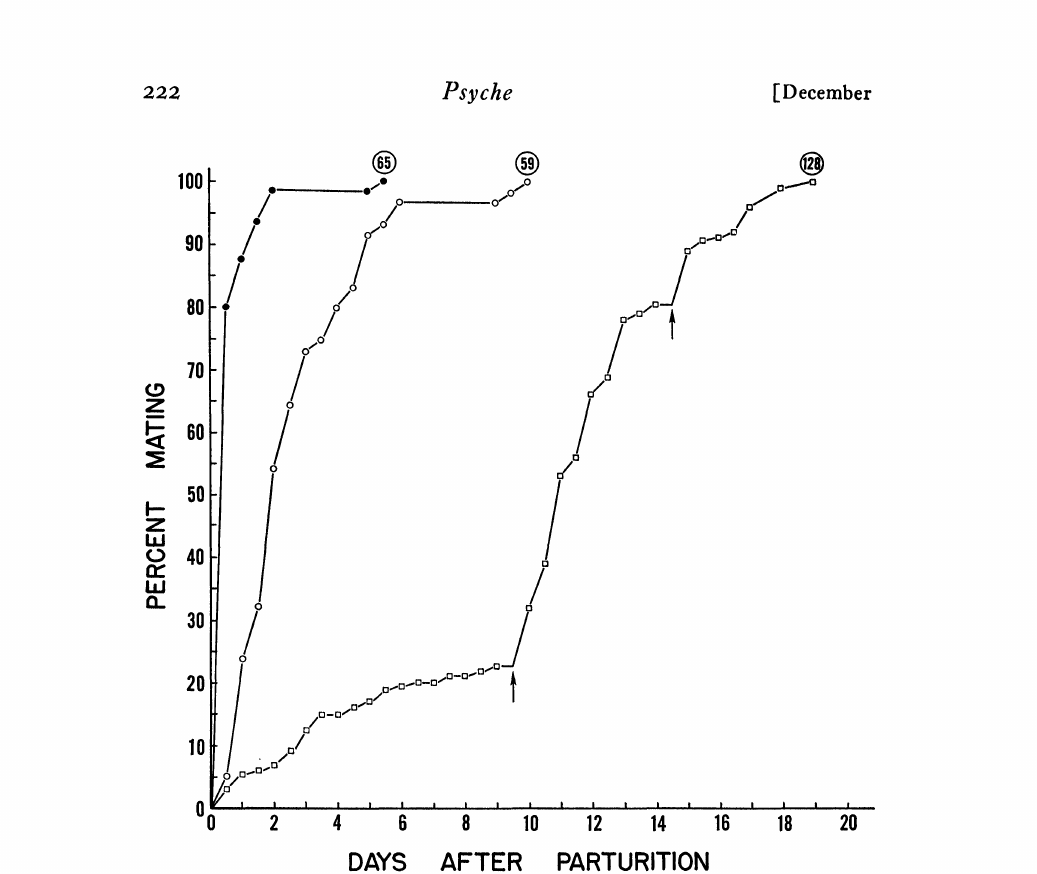
Fig. 14. Effect of starvation on receptivity of N. cinerea following parturition. Solid circles Females fed during gestation and after partu- rition; average days to mate after parturition was 0.7 + 0.3. Open circles Females starved during gestation, then exposed to males and food after parturition; 59 of 60 females mated; average days to mate after parturition was 2.8 + 0.2. Open